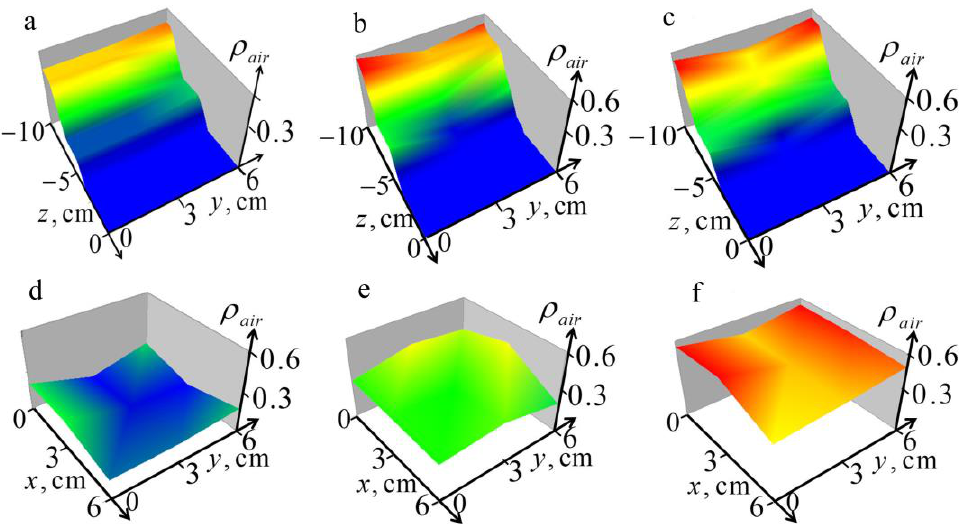
Figure 9. Tomography sections of the retrieved 3D air content distribution in lungs: ( a – c ) images in the vertical sections at x = 0, 3, 6 cm; ( d – f ) images in the horizontal sections z = − 5, − 7, − 9 cm.